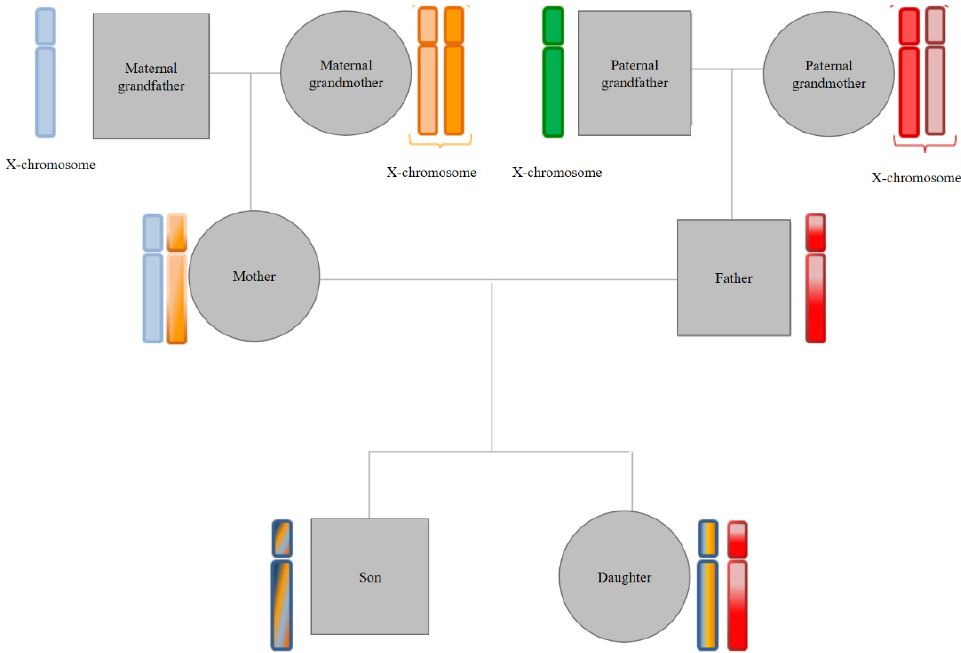
Figure 2. X-chromosome transmission from the maternal and paternal sides. The recombination of the genetic information